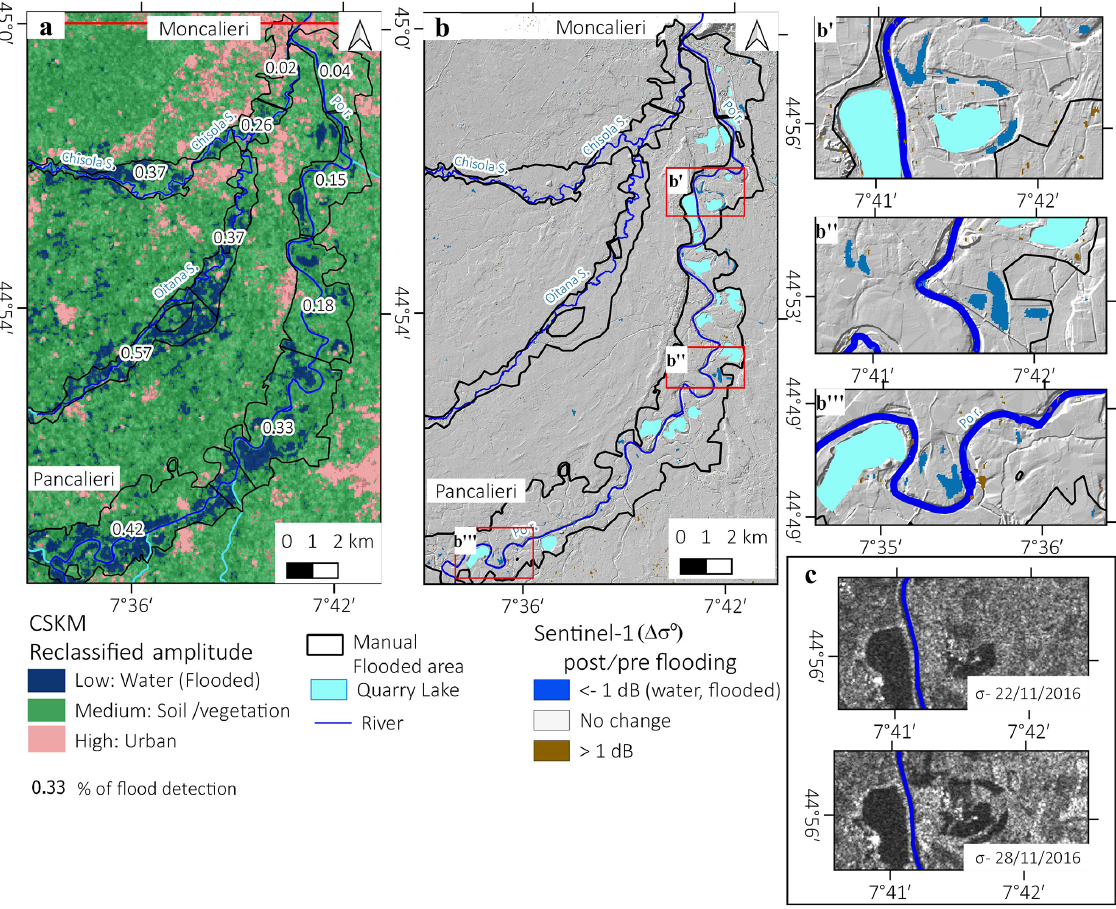
Figure 3. (a) Reclassified Quicklook Amplitude SAR Image acquired at 05:05UTC, 25 November 2016 – COSMO-SkyMed©ASI [2016]. (b) Sentinel-1 geocoded backscattering coefficient difference ( (cid:49)σ ◦ ), (b’, b” and b”’) and details of some areas where (cid:49)σ ◦ still detect water. (c) Example of change backscattering between the pre- and the postflood image is